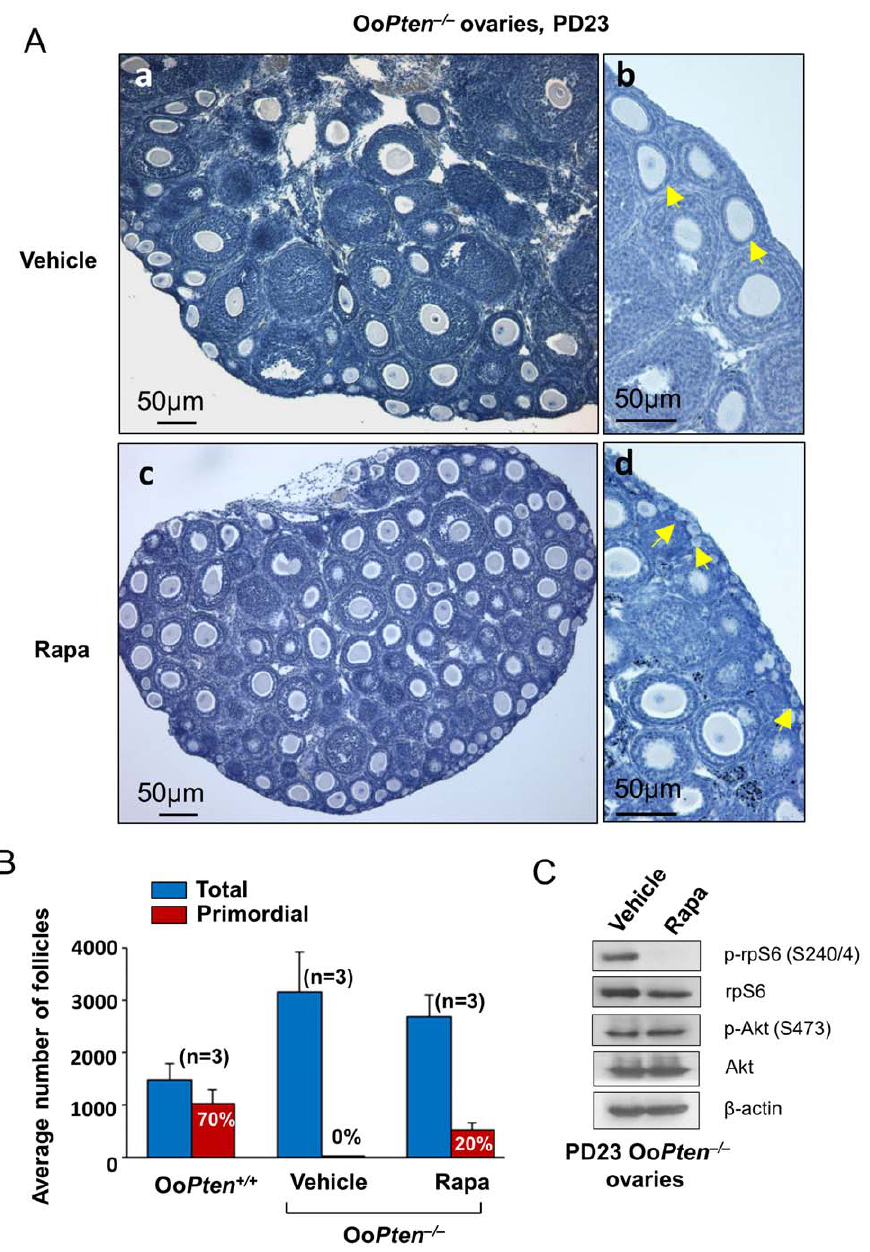
Figure 2. Preservation of the primordial follicle pool in Oo Pten 2 / 2 ovaries by rapamycin treatment. ( A ) Prevention of the primordial follicle over-activation in Oo Pten 2 / 2 mice by treatment with rapamycin. Rapamycin (5 mg/kg body weight) was injected daily into Oo Pten 2 / 2 mice from postnatal day (PD) 4 to PD 22, and the ovaries were collected at PD 23 for morphological analysis. Ovaries from rapamycin-treated Oo Pten 2 / 2 mice appeared smaller (c) than the ovaries from vehicle-treated Oo Pten 2 / 2 mice (a). Scale bar=50 m m. Clusters of primordial follicles were seen in rapamycin-treated Oo Pten 2 / 2 mice at PD 23 (d, arrows) whereas all primordial follicles were activated in vehicle-treated Oo Pten 2 / 2 mice at PD 23 (b, arrows). Scale bar=50 m m. ( B ) Average numbers of total and primordial follicles in Oo Pten + / + , Oo Pten 2 / 2 (vehicle-treated), and Oo Pten 2 / 2 (rapamycin-treated) ovaries at PD 23. Proportions of primordial follicles 6 SEM (relative to the total number of follicles) are also shown. The proportion of primordial follicles in rapamycin-treated Oo Pten 2 / 2 ovaries was 20 6 4.1%, which was smaller than the proportion in the Oo Pten + / + ovaries (70 6 3.1%). Three mice were used for each experimental group. Rapa, rapamycin. ( C ) Comparison of the rpS6 and Akt phosphorylation levels in the ovaries of vehicle- and rapamycin-treated Oo Pten 2 / 2 mice. Rapamycin (5 mg/kg body weight) was injected daily into Oo Pten 2 / 2 mice from PD 4 to PD 22, the ovaries were collected at PD 23 and homogenized, and immunoblotting was performed as described in Materials and Methods . Rapamycin injection effectively suppressed the level of phosphorylated rpS6 (p-rpS6) without affecting the level of phosphorylated Akt (p-Akt) in the ovaries of Oo Pten 2 / 2 mice. Levels of total rpS6, Akt, and b -actin were used as internal controls.